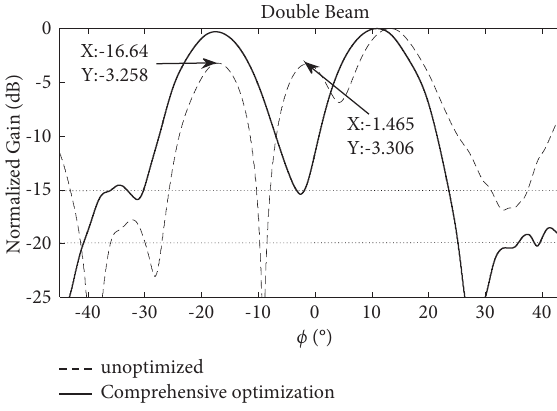
Figure 10: Two beams separated by 30 ° .